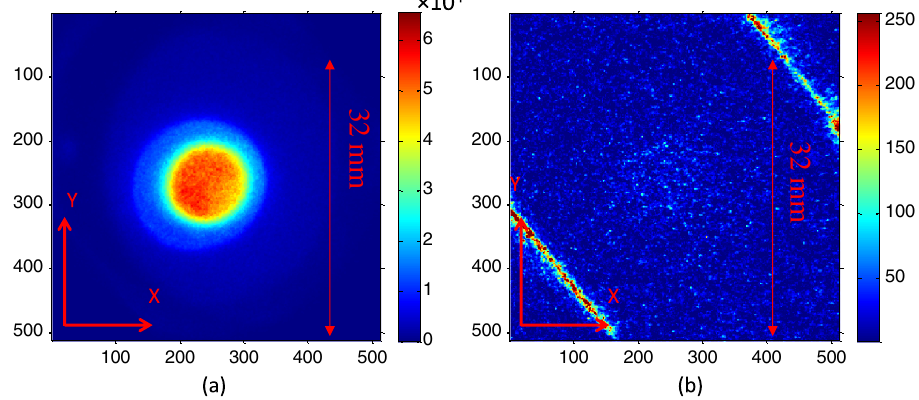
FIG. 11. (a) Image with all DMD pixels set to þ 12 (cid:5) ; (b) image with all pixels set to (cid:2) 12 (cid:5) ; vertical and horizontal coordinates are given in terms of CCD pixels